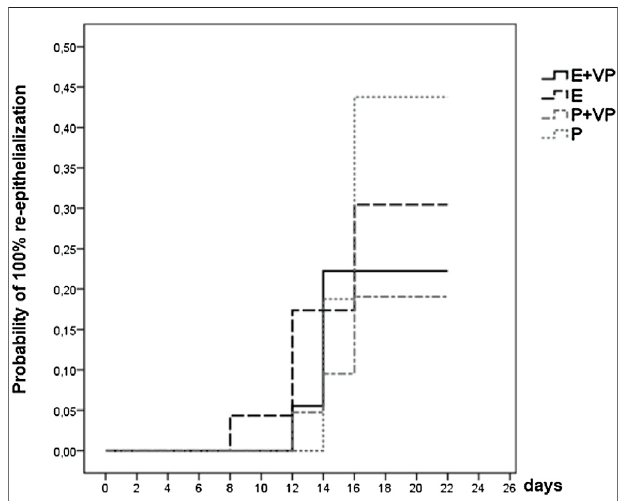
FIGURE7| Survivalfunction ofsubgroup “ VP ” vs. “ noVP ” . Showing the likelihood of 100% re-epithelialization through day 21 for patients from four subgroup strata whose study wound healing process was fully documented (data were censored for 56 (72%) patients).